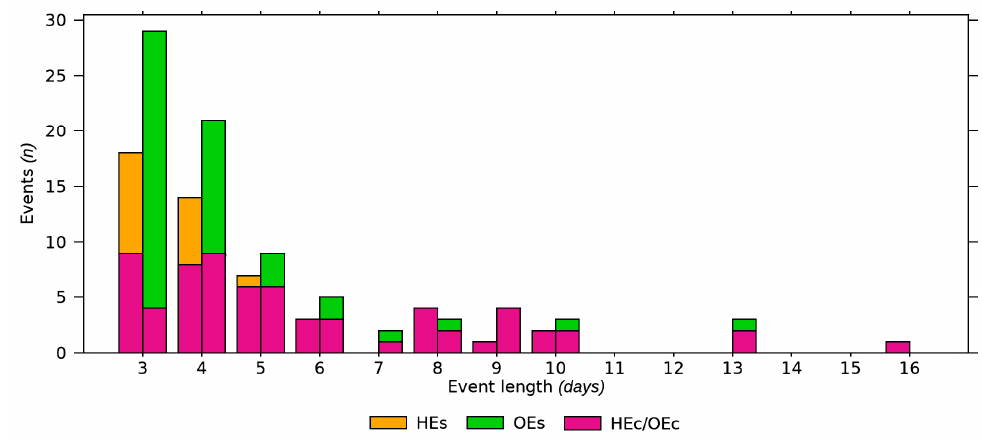
Figure 9. Stacked bars for the number of events per length of HEs (T mean > 22 °C, orange), OEs (MDA8 > 100 µg m − 3 , green), and corresponding coupled events (HEc/OEc, purple) in Berlin from 2000 to 2014.